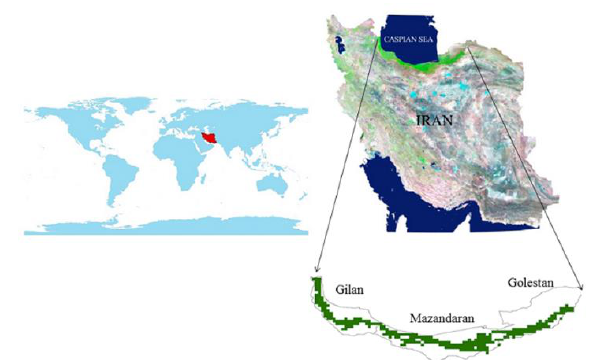
Figure 1: Geographical location of Iran (left) and of the Hyrcanian forests, extending over the Iranian provinces of Guilan, Mazandaran and Golestan